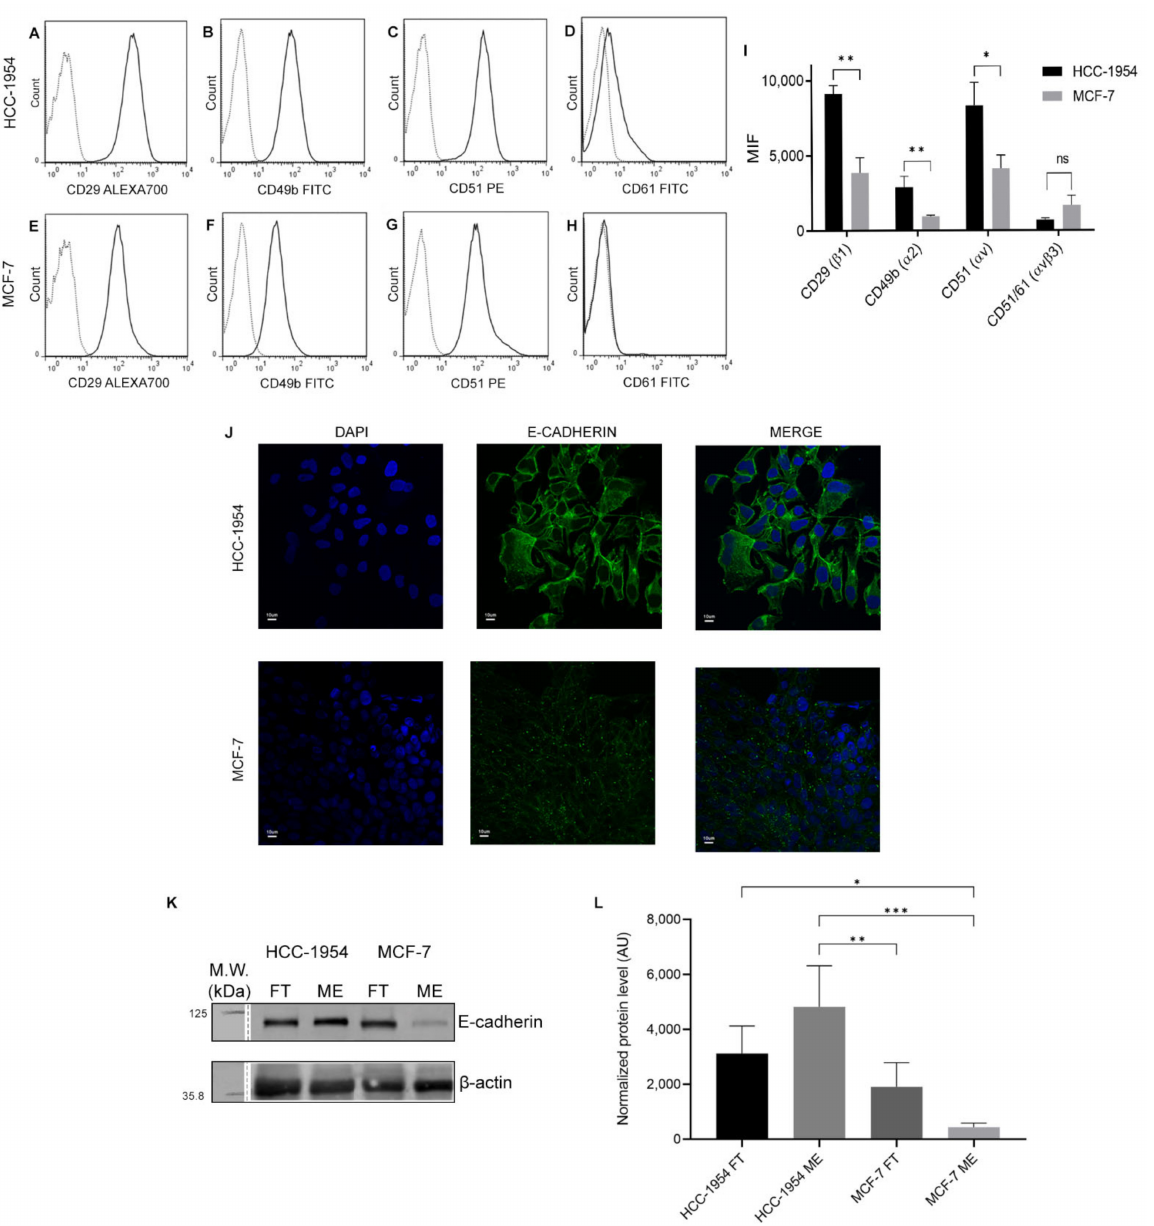
Figure 4. Integrin phenotypes and E-cadherin protein expression of HCC-1954 and MCF-7 human breast cancer cell lines. Histograms shows the expression of CD49b, CD51, CD29, and CD51/CD61 ( A – D ) in HCC-1954 and ( E – H ) in MCF-7 cell lines. Dotted grey lines are unstained controls. ( I ) shows the median fluorescence intensity (MFI) of three independent experiments. ( J ) Immunofluorescence of E-cadherin in HCC-1954 and MCF-7 cell lines. ( K ) Western blot of E-cadherin in total extract (TE), flow-through (FT) and membrane-enriched (ME) fractions of HCC-1954 and MCF-7 cell lines. ( L ) Western blot quantification of three independent experiments. p -value < 0.05 (*); <0.01 (**); <0.001 (***). Raw data of Western blot membrane are shown in Supplementary Figure